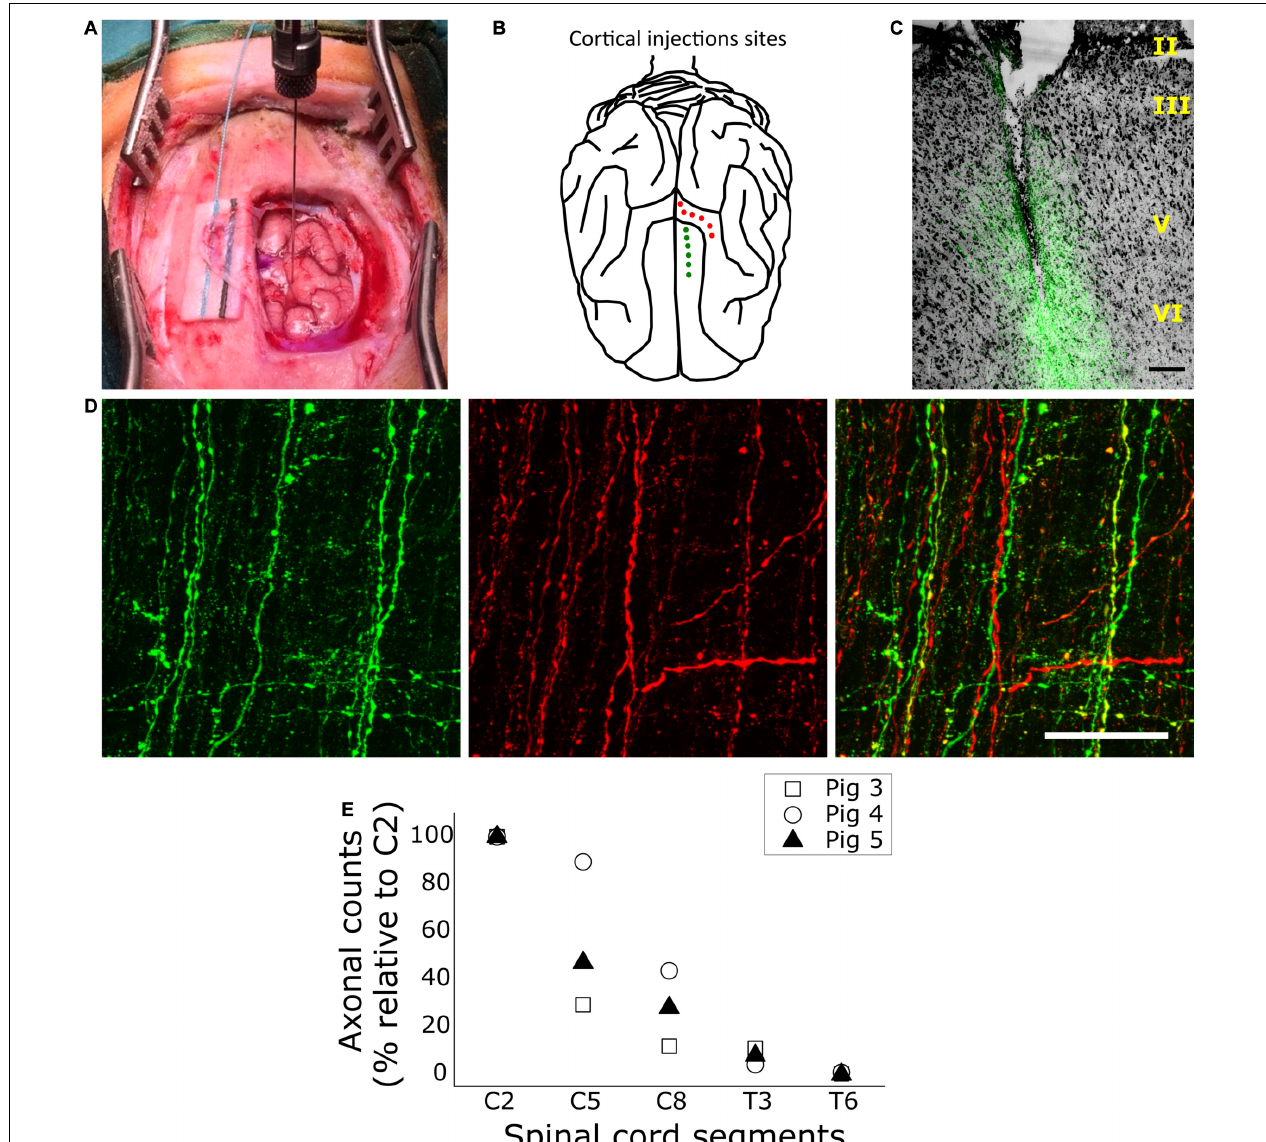
FIGURE 3 | Anterograde tracing of the corticospinal tract (CST). (A) Intraoperative photograph of the surgical approach with an injection of tracer being applied in the left cruciate gyrus. (B) Illustration depicting the cortical injections sites in the porcine cerebral cortex. Red points illustrate injection sites in the cruciate gyrus and green points illustrate injection sites in the frontal superior gyrus. (C) Exemplification of a cortical injection site in the frontal superior gyrus, generated by merging transmitted light (for visualizing Toluidine blue) and fluorescence (for Alexa 488-conjugated dextran). Scale bar, 200 µ m. (D) Confocal fluorescence images of corticospinal axons in the right dorsolateral funiculus of the C7 spinal cord segment, taken from a horizontal, 50- µ m-thick section at ∼ 2,300 µ m of depth in the dorsal-ventral plane. Axons arising from the premotor cortex appear in green, and those from M1 appear in red. Scale bar, 50 µ m. (E) Quantification of CST axons within the white matter of different spinal cord segments, shown as a percentage relative to axons counted at C2 in the same animal. Data represent axon counts for each pig as indicated in the